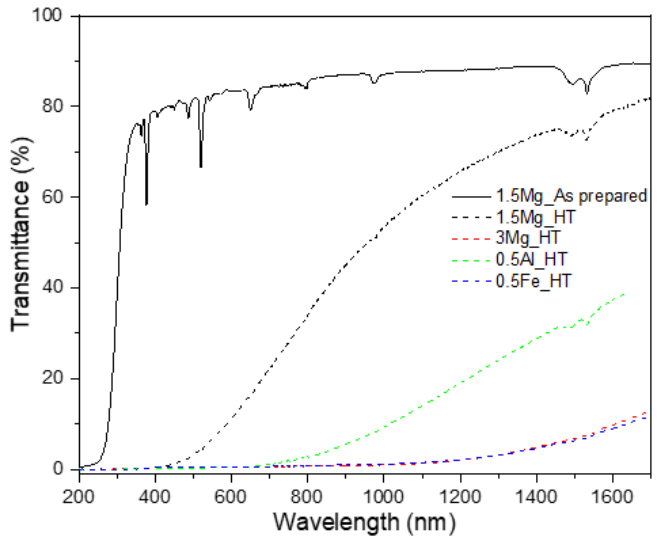
Figure 2. Transmittance spectrum of the as-prepared 1.5 Mg glass taken as an example as all the as-prepared glasses exhibit similar transmittance spectra (solid line) and of some heat-treated (HT) glasses (dashed line).